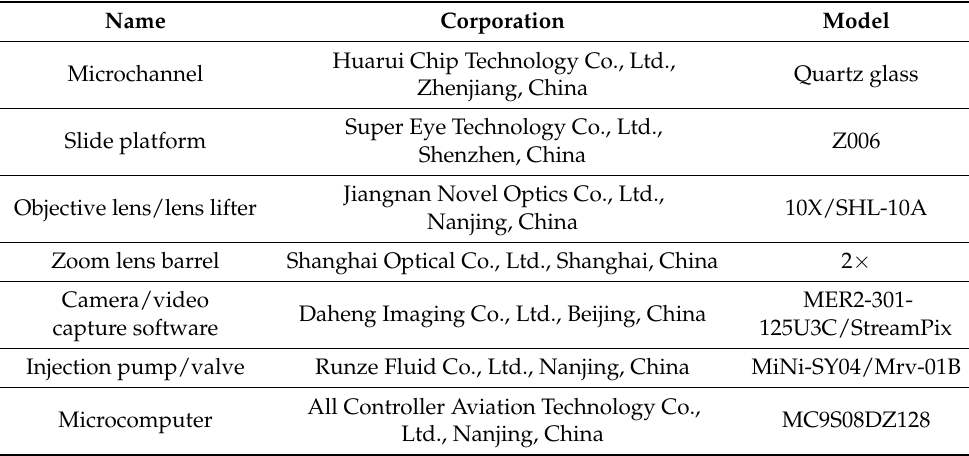
Table 2. Details of the apparatus used in this